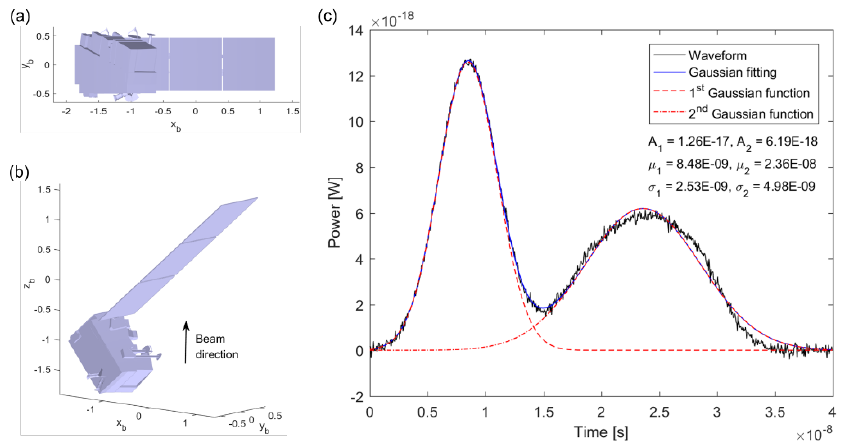
w.r.t. Figure 2a.